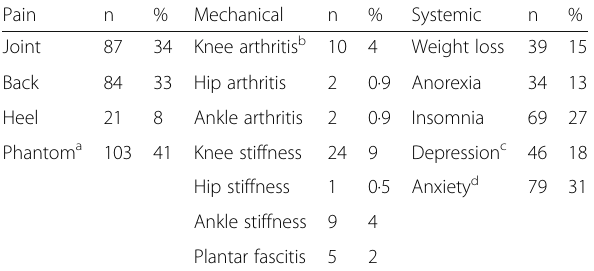
Table 5 Medical and psychological